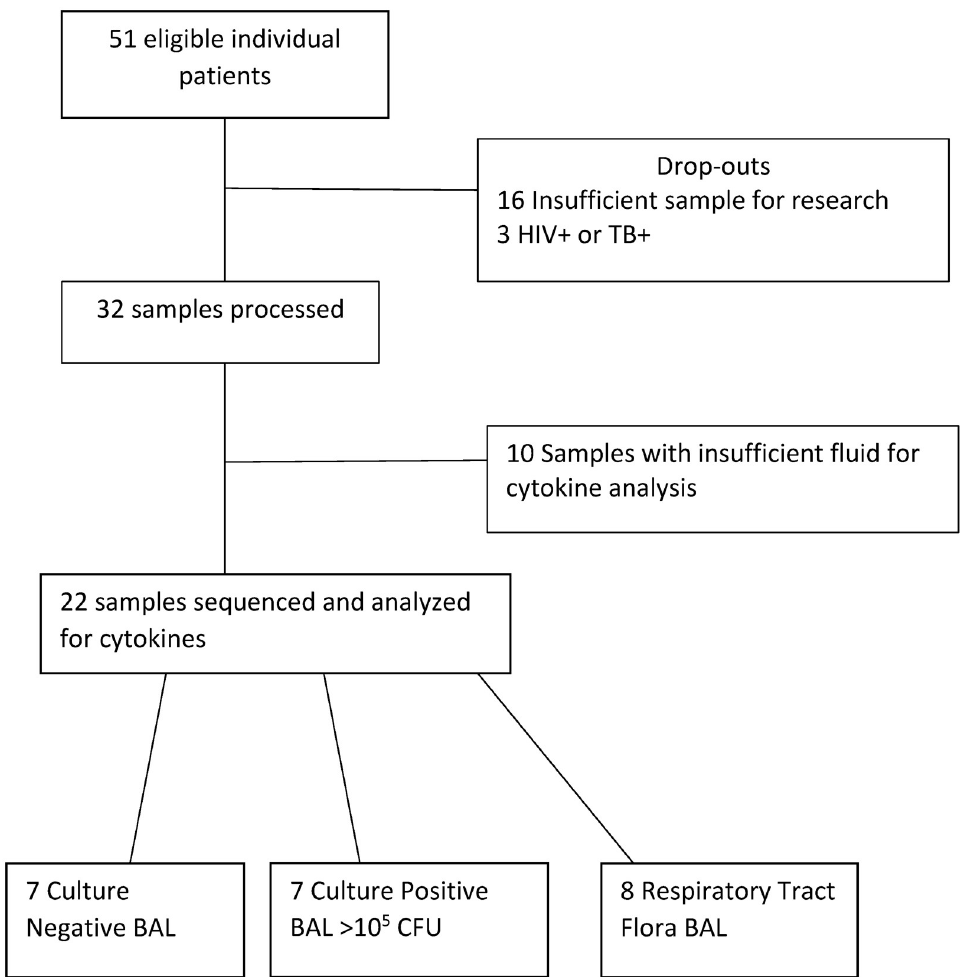
Fig 1. Flowchart of bronchoalveolar lavage samples collected from the surgical intensive care unit.